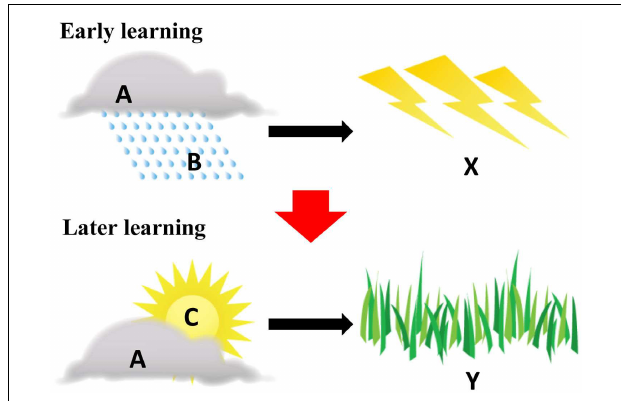
FIGURE 1 | Structure of a highlighting example. A, B, and C (clouds, high humidity, and low humidity, respectively) are predictive cues. X (thunderstorm) andY (nice sunny day) are outcomes.The broad red arrow signifies the order of learning (e.g., first Early learning, then Late